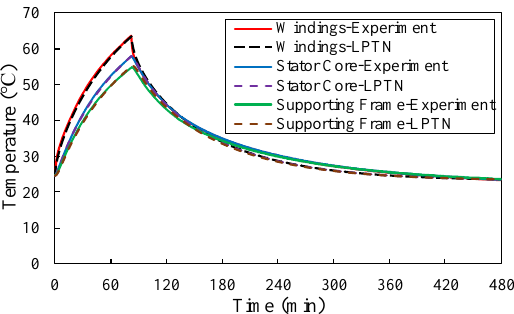
Figure 21. Instantaneous temperature-rise test of the prototype under 12 A DC.